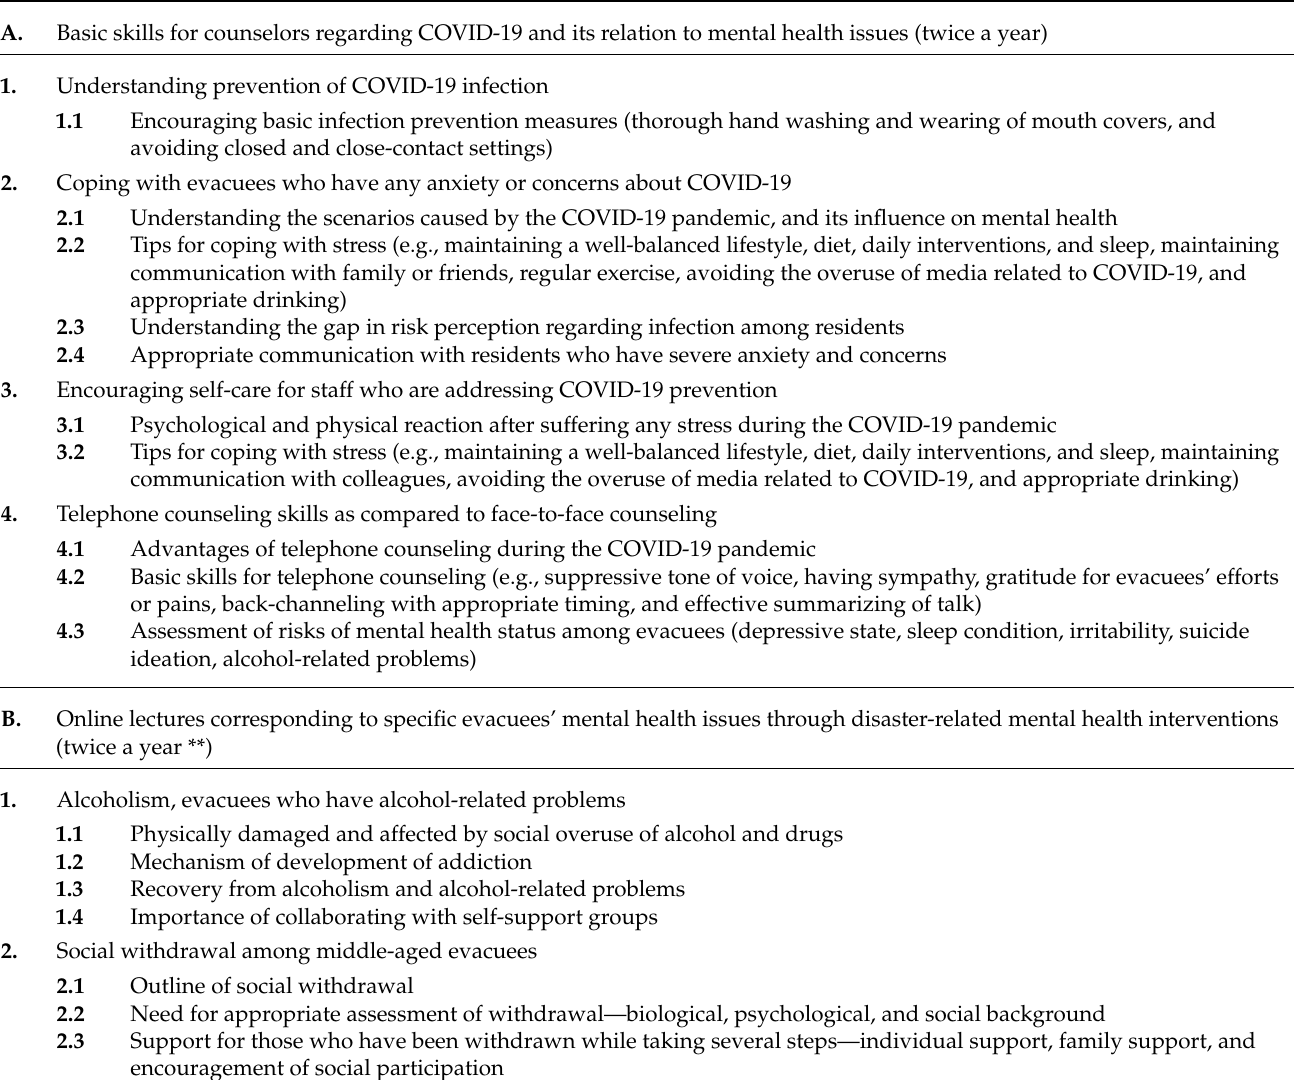
Table 2. Online training seminar on human resources development regarding disaster-related mental health interventions during the COVID-19 pandemic